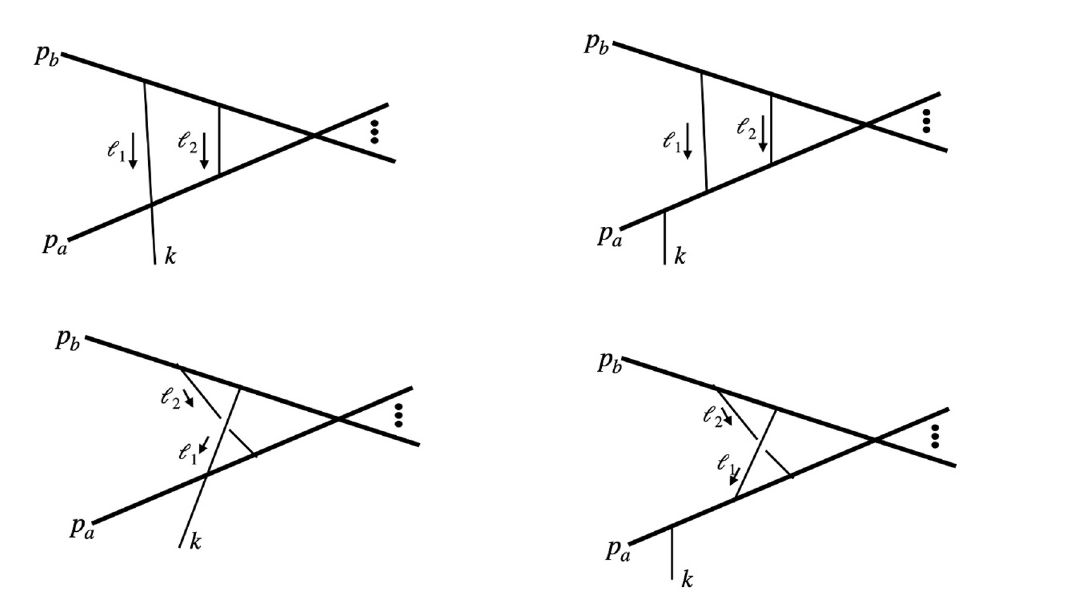
JHEP12(2020)070